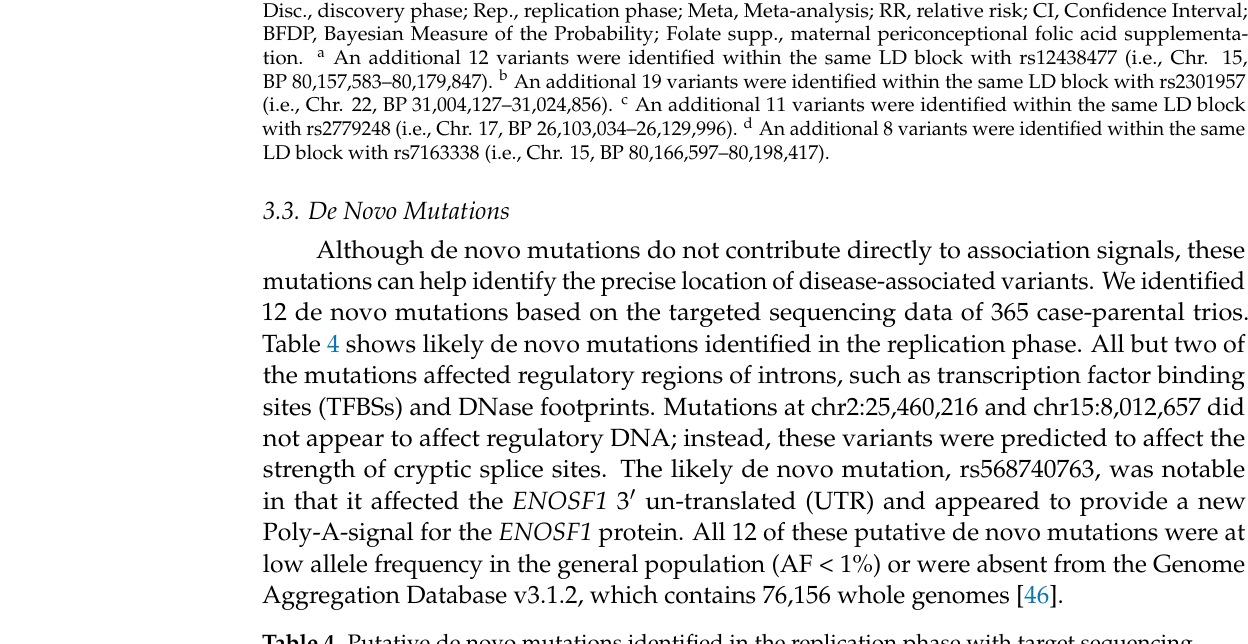
Table 4. Putative de novo mutations identified in the replication phase with target